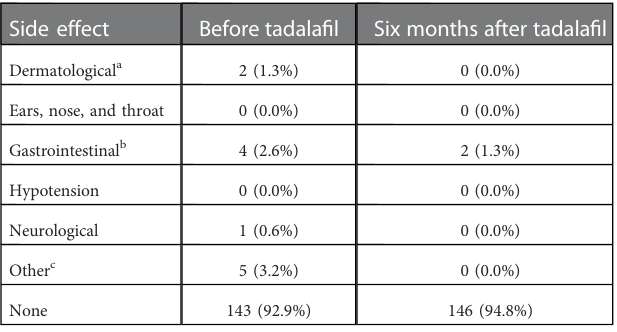
TABLE 3 Adverse effects of treatment before and six months after tadala fi l initiation, summarized as count